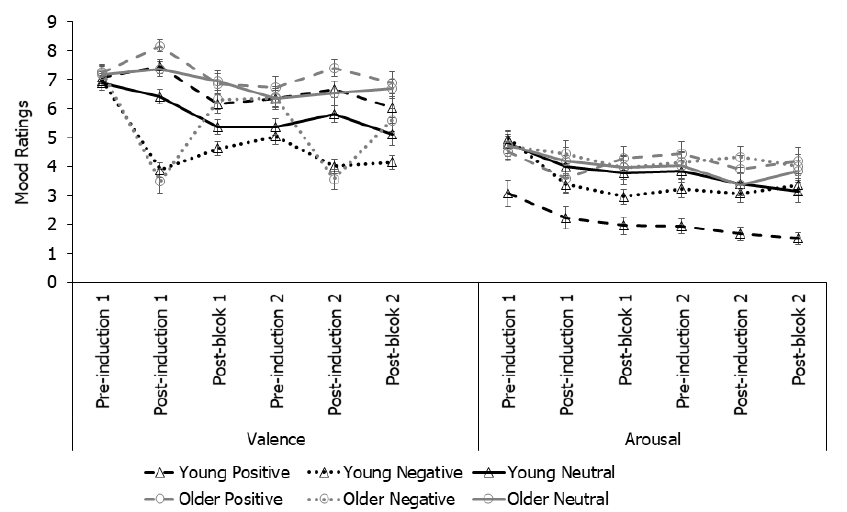
Figure 5. Mean valence and arousal ratings of mood in Experiment 2. Ratings: 1 = most negative (i.e., sad) or lowest arousal; 9 = most positive (i.e., happy) or highest